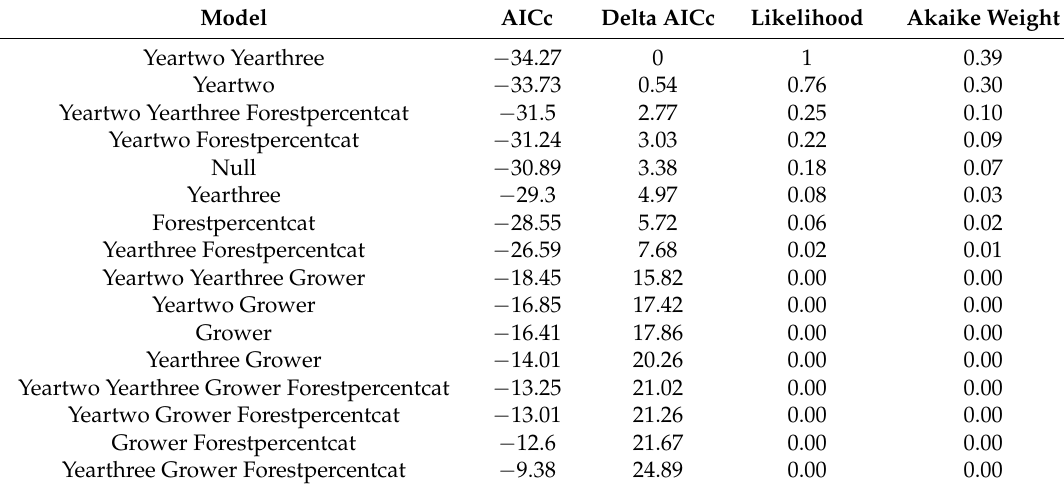
AICc: Akaike information criterion corrected for small sample size.